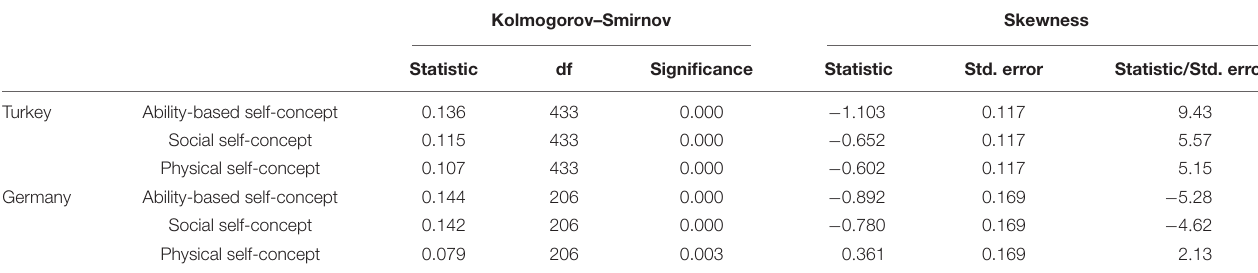
TABLE 1 | Results on the normal distribution for Turkey and Germany data.